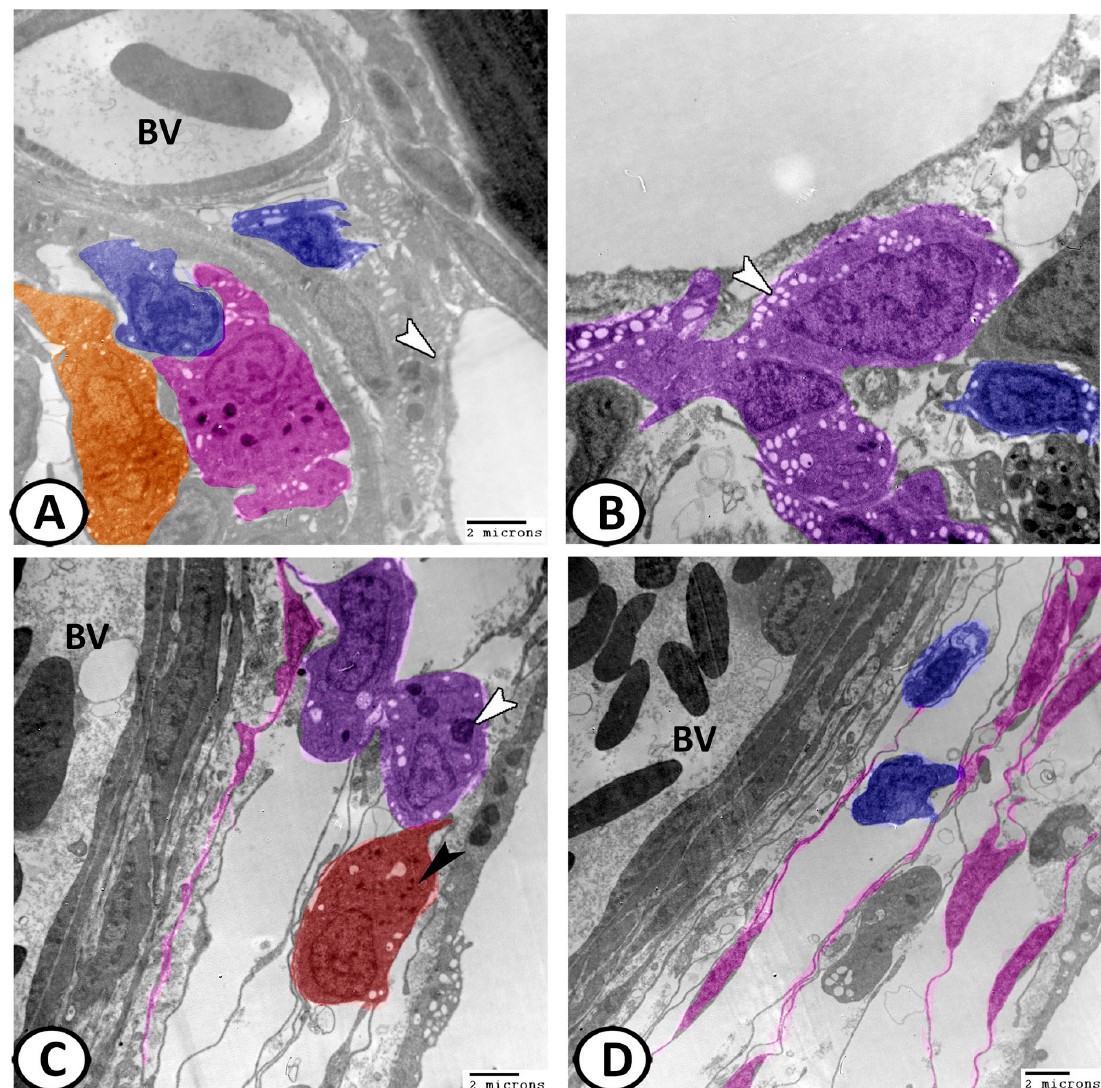
Figure 10. Digital colored TEM images of gills. ( A ) Lymphocytes (blue), macrophages (pink), and stem cells (orange) around the blood vessels (BV) in the interstitial connective tissue between gill lamellae. ( B ) Lymphocytes (blue) and monocytes (violet) with many vacuoles (arrowhead). ( C ) Macrophages (violet) contained heterogeneous contents (white arrowhead) and neuroepithelial cells (red) contained electron-dense granules (black arrowhead). Note the distribution of telocytes (pink) around the blood vessels (BV). ( D ) Many lymphocytes (blue) and telocytes (pink) are around the blood vessels (BV).